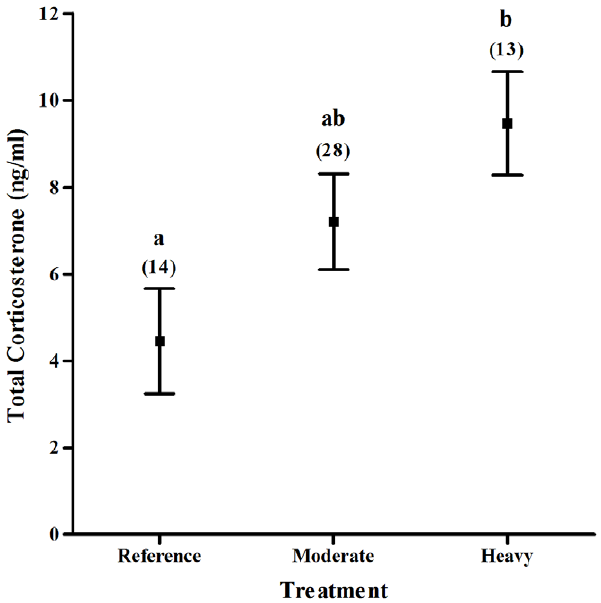
Figure 3. Effect of harvesting treatment on the mean corticosterone levels in broods of Ovenbird nestlings. Brood corticosterone levels were significantly higher in the Heavy logging treatment than the Undisturbed logging treatment ( P =0.003). The number of nestlings and the number of broods within each treatment respectively are in parentheses. Means and SE are presented. Different letters indicate significant differences using Tukey’s unequal N HSD post hoc